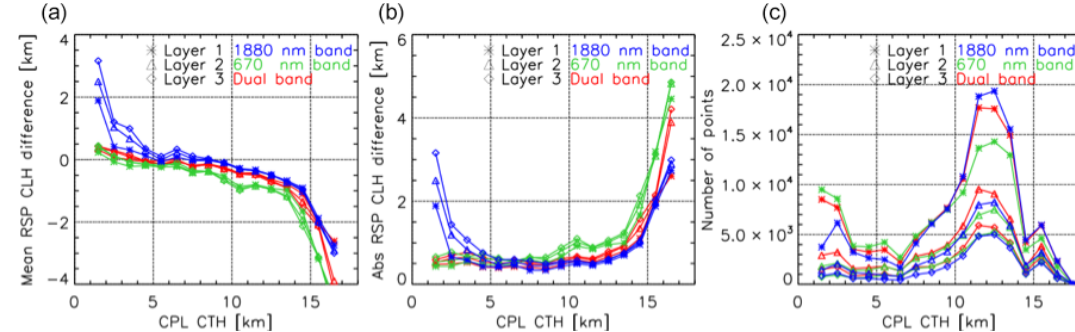
Figure 10. RSP mean error (a) , absolute error (b) and number of clouds (c) versus CPL CTH.